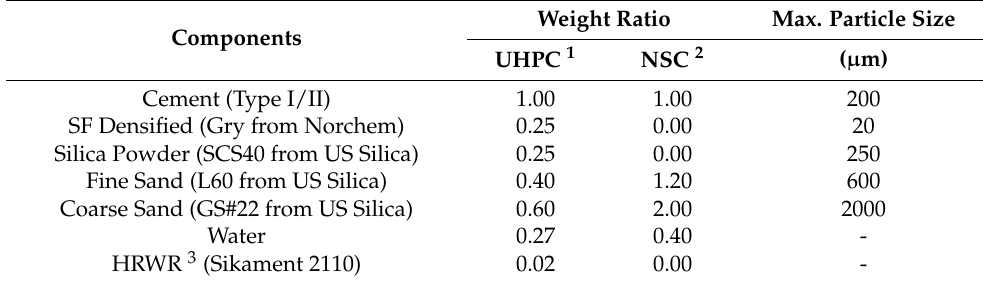
Table 3. Material properties of NSC and